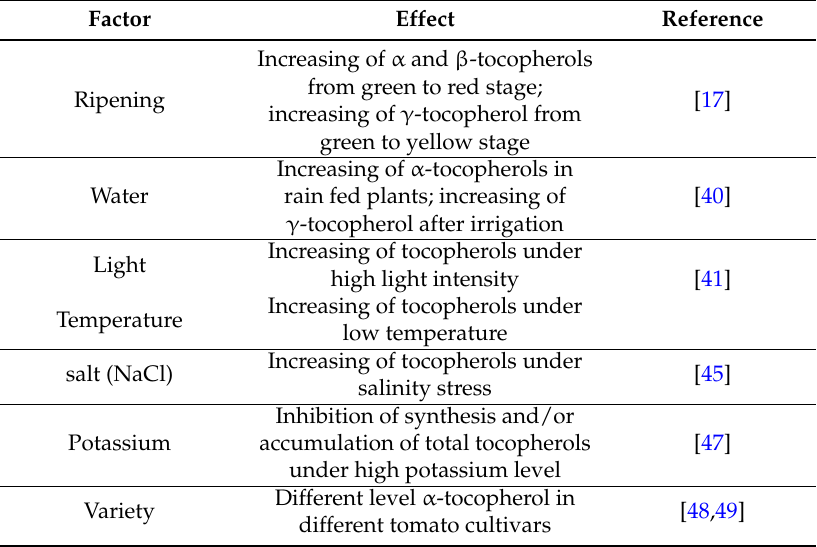
Table 2. Main factors influencing VTE